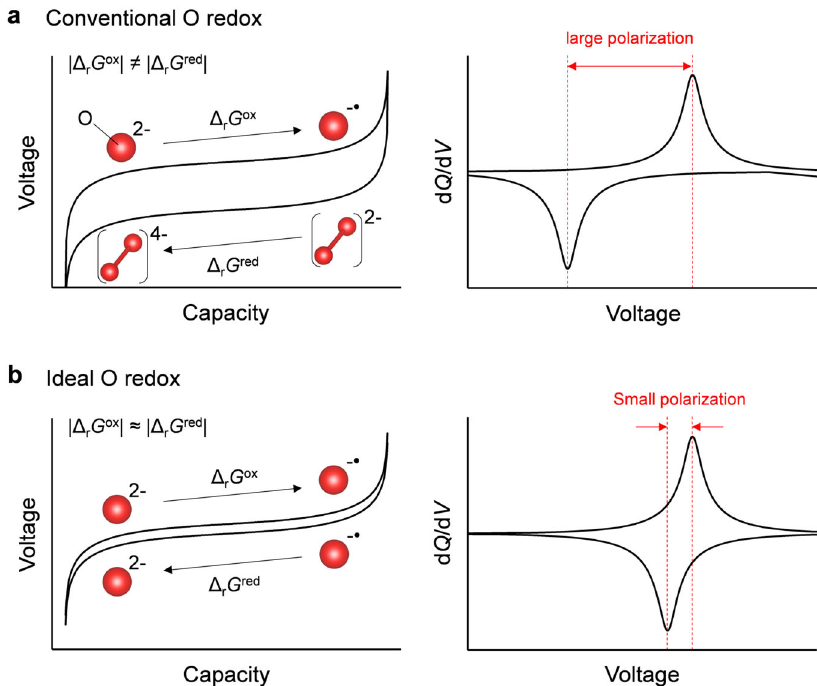
Fig. 1 Polarizing and nonpolarizing oxygen-redox positive electrodes. Schematic illustration of charge/discharge curves and d Q /d V plots ( Q : speci fi c capacity, V : reaction voltage) for a conventional oxygen redox with large polarization (O 2 − /O 2 2 − ), and b ideal oxygen redox with small polarization (O 2 − /O − (cid:129) ). The red sphere denotes oxygen